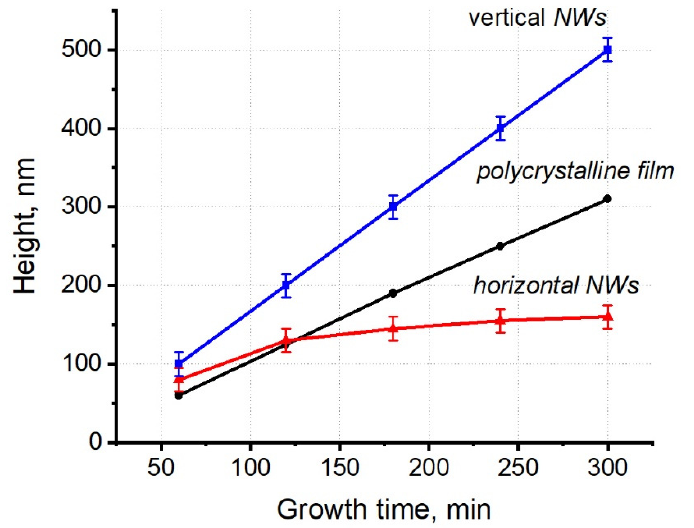
Figure 7. Dependence of the height of the VO 2 NWs and a polycrystalline VO 2 film on the synthesis time.